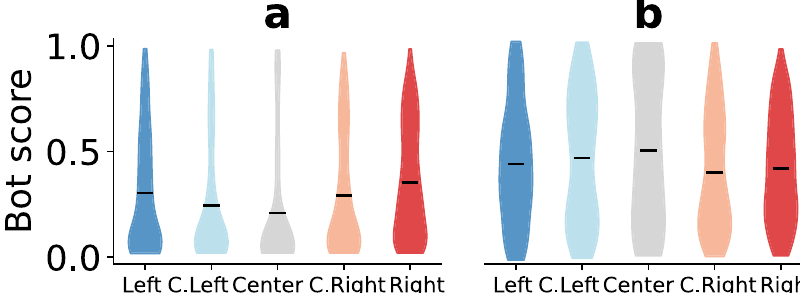
Fig. 3 Distributions of the bot scores of friends and followers of drifters. The bot score is a number between zero and one, with higher scores signaling likely automation. For each group, we consider the union of a friends and b followers of the drifters in that group. Bars indicate averages. For friends, n = 282 (Left), 261 (C. Left), 206 (Center), 323 (C. Right), and 414 (Right). For followers, n = 172 (Left), 118 (C. Left), 65 (Center), 205 (C. Right), and 299 (Right). Source data are provided as a Source data fi